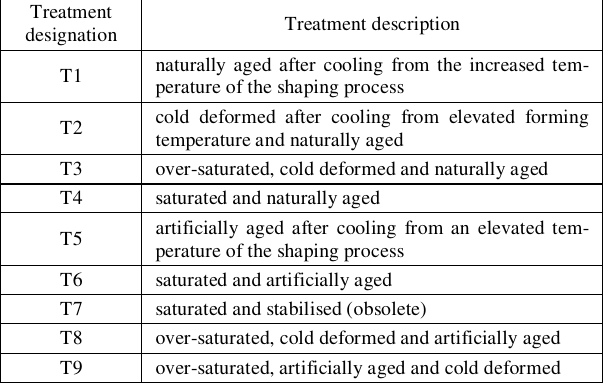
Table 3. Designation of heat treatment process conditions [6] Treatment